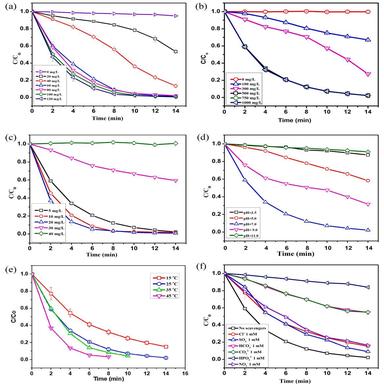
Effects of (a) catalyst content, (b) PMS content, (c) RhB concentration, (d) solution pH, (e) reaction temperature, and (f) anion on RhB removal.